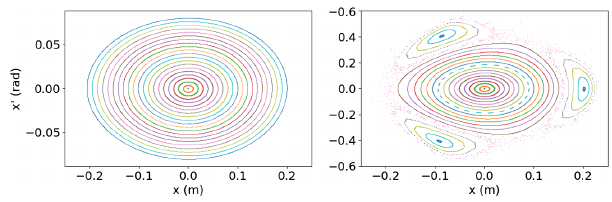
FIG. 3. Initialized from maps the TM-PNN accurately repre- sents the parametric dependency of dynamics on magnet strength, such as the appearance of a third-integer